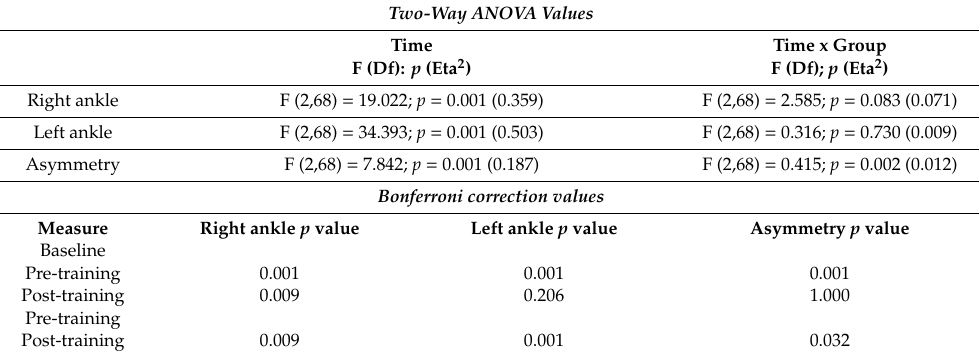
Table 4. Two-way ANOVA and Bonferroni correction values for the intra-subject e ff ects of the total